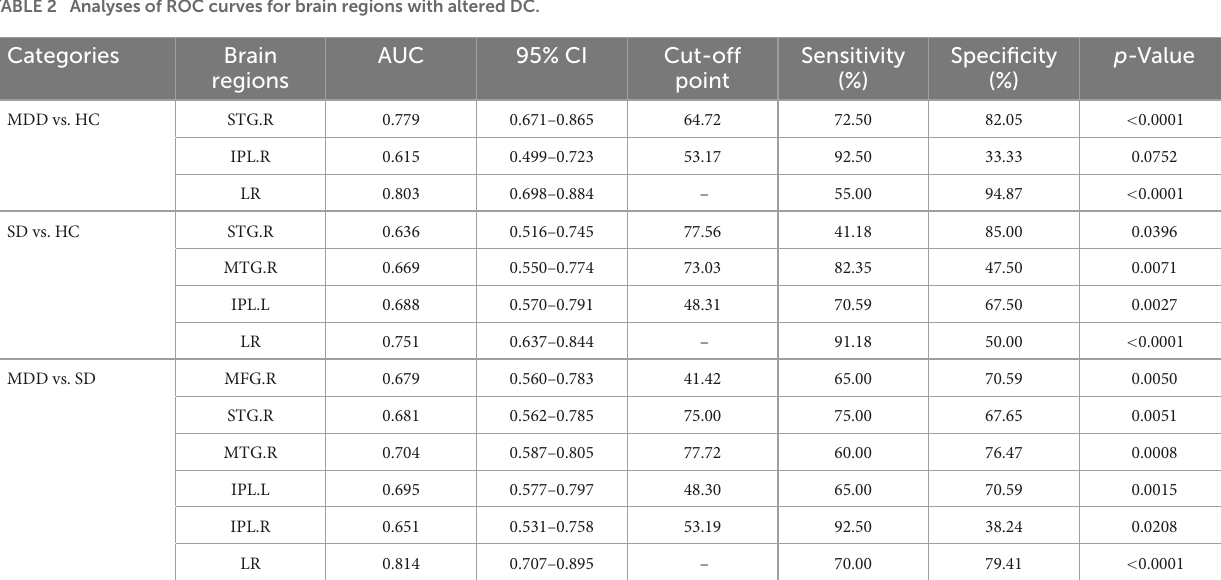
TABLE 2 Analyses of ROC curves for brain regions with altered